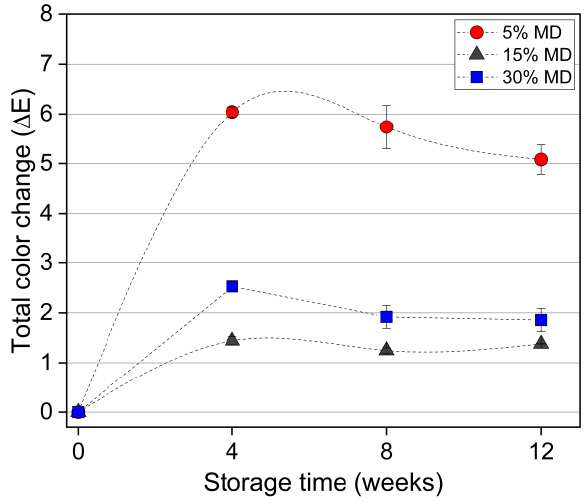
Figure 4. Total color changes of dried raspberry foam samples during a 12-week storage period. The foam samples contained 5% ( w / w ) PP + 2.5% ( w / w ) P at various MD concentrations (reference: week 0 of each sample).